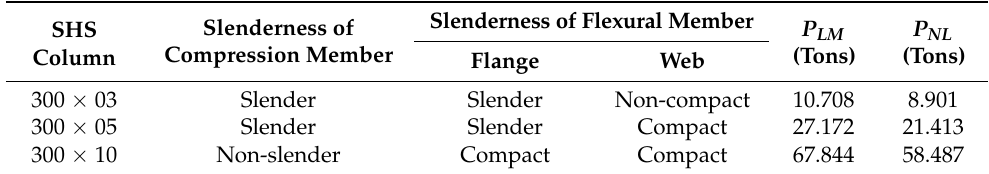
Table 1. Maximum crane loads of unstiffened SHS columns.